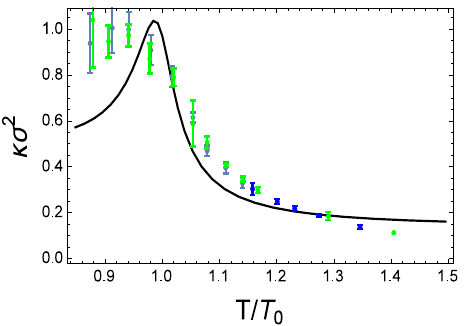
Figure 1. (cid:20)(cid:27) 2 as functions of the normalized temperature T=T 0 with T 0 = 217 MeV the pseudo critical temperature at zero chemical potential (cid:22) = 0. The black line is for h ((cid:8)) = 7 = 10 which is in agreement with lattice results in ref.